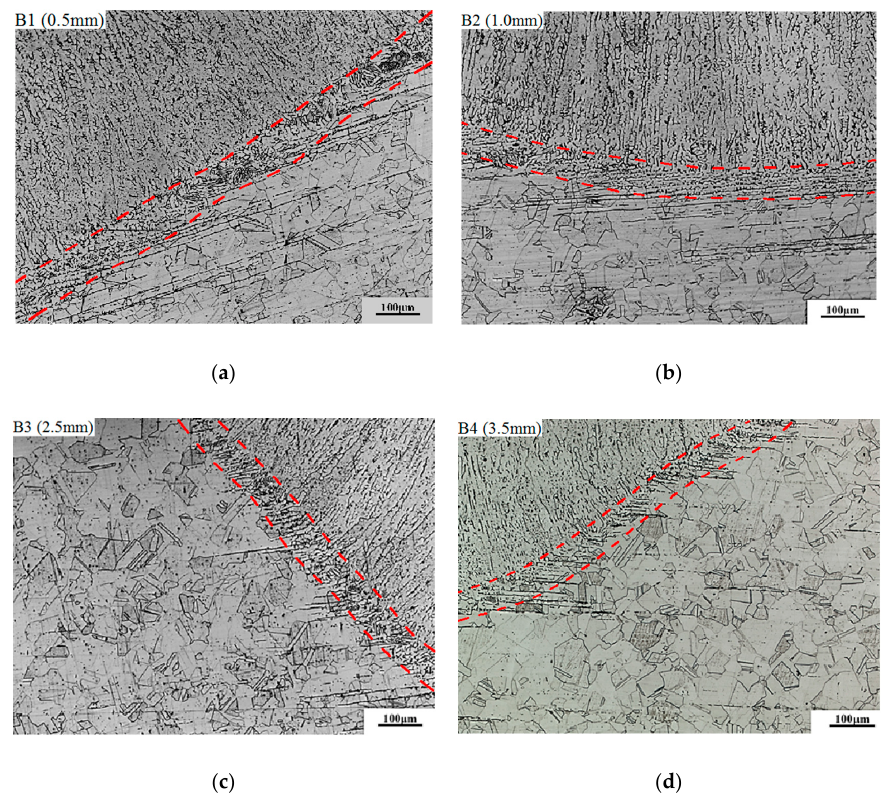
Figure 8. E ff ect of repair weld reinforcement height on the microstructure in the fusion line and the adjacent region: ( a ) 0.5 mm, ( b ) 1.0 mm, ( c ) 2.5 mm and ( d ) 3.5